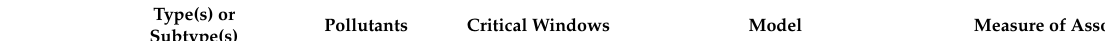
Table 5. Definitions of measures of association for